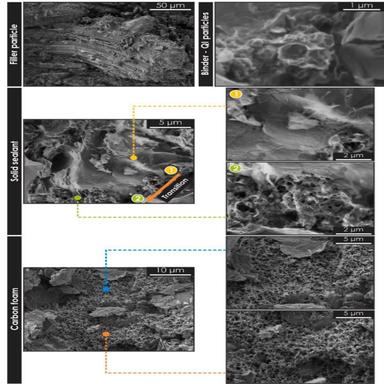
SEM micrographs obtained from fractured surfaces of CGB graphite.